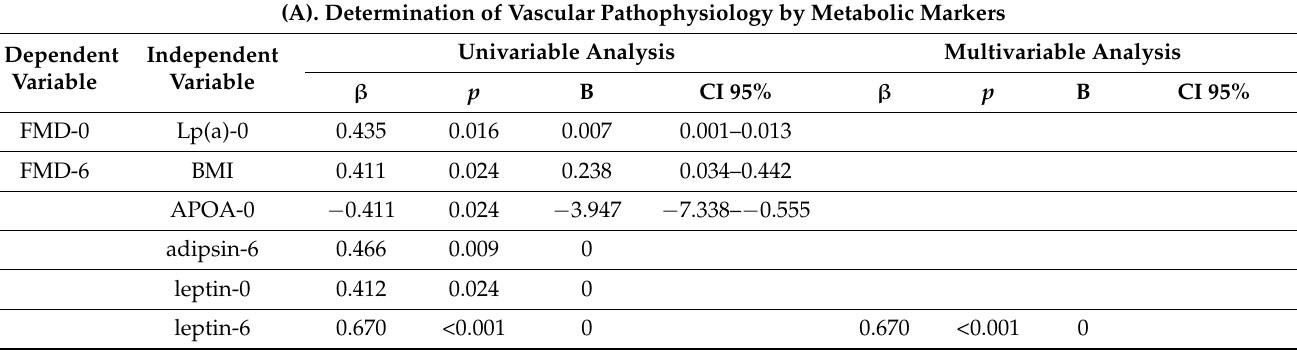
Table 2. Univariable and Multivariable Regression Analysis of Metabolic and Vascular